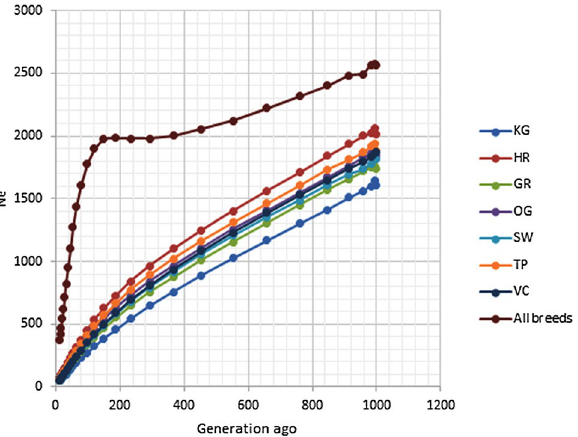
Figure 3. Effective population size ( Ne ) of Indian cattle breeds for a number of generations. X and Y axis represents generation and Ne,